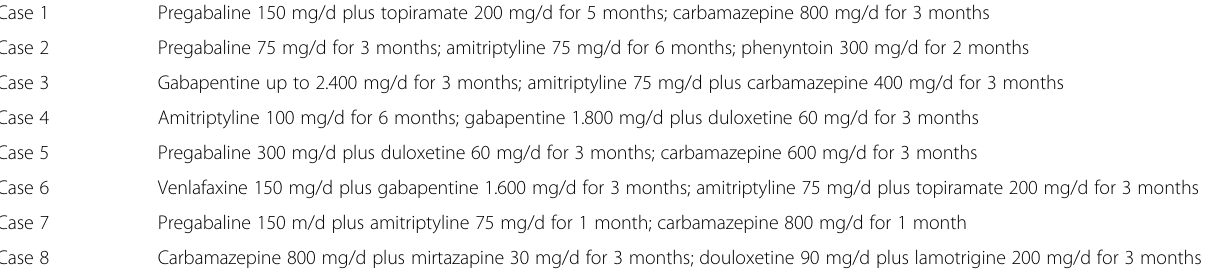
Table 2 Previous treatments that failed to improve